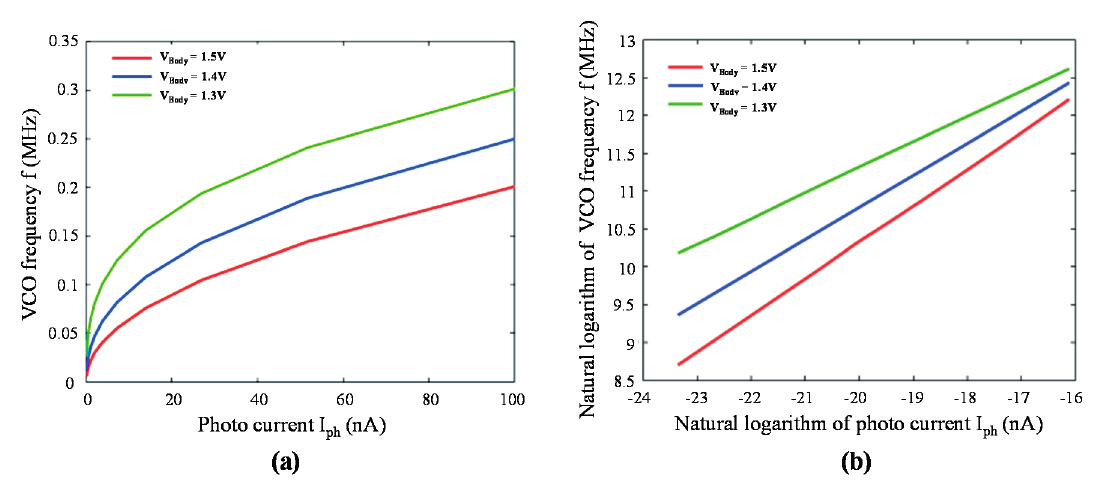
Figure 7. The simulated VCO frequency vs. photocurrent with different V Body in ( a ) linear space; ( b ) natural logarithmic